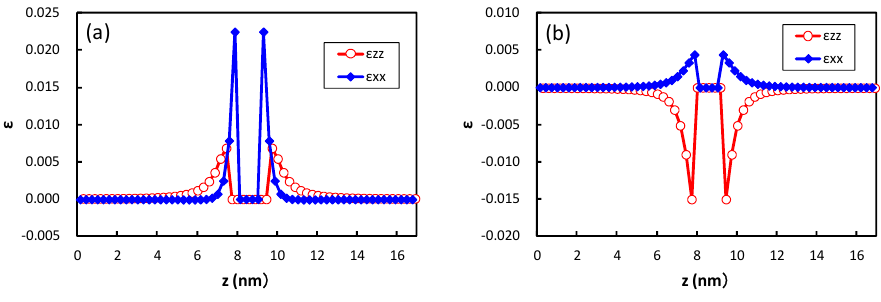
Figure 5. Strain at the center of the broad plane of the precipitate along the direction perpendicular to the broad plane of precipitate with an ( a ) coherent and ( b ) semi-coherent interface. The x - and z -directions are parallel and perpendicular to the broad plane of the precipitate,